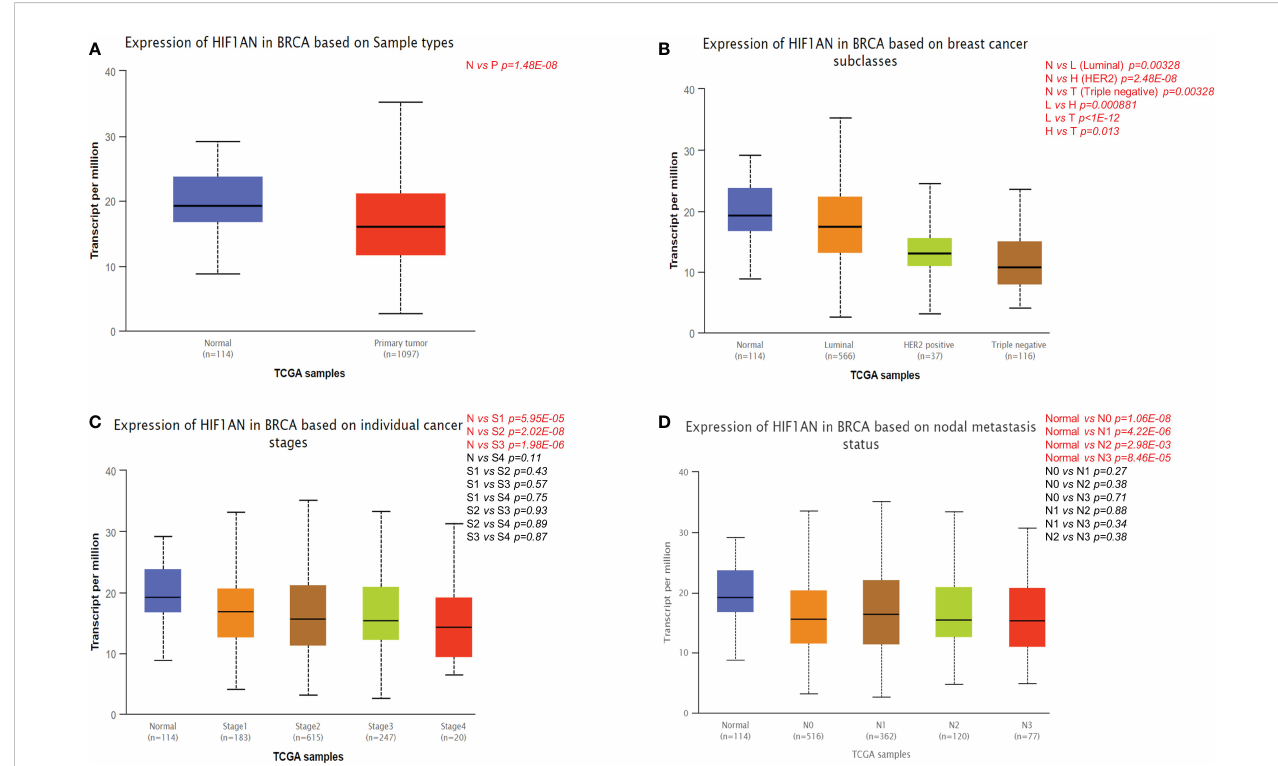
FIGURE 2 Correlation between HIF1AN expression level and clinicopathological variables of BC through the UALCAN datasets. (A) HIF1AN expression was remarkably downregulated in breast primary tumor than that in normal tissues. (B) HIF1AN expression was lower in luminal, HER2 positive and triple negative BC than in normal tissues. (C) HIF1AN expression in middle-stage and late-stage BC was substantially lower than in the early phase. (D) HIF1AN expression at all stages of lymph node stage specimens was substantially lower in BC than in healthy one; P, primary tumor; S1, stage 1; S2, stage 2; S3, stage 3; S4, stage